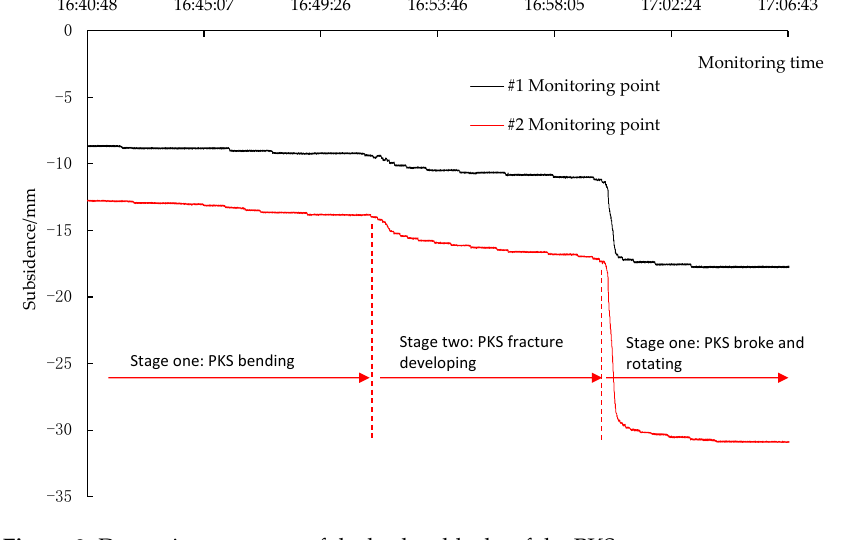
Figure 9. Dynamic movement of the broken blocks of the PKS.